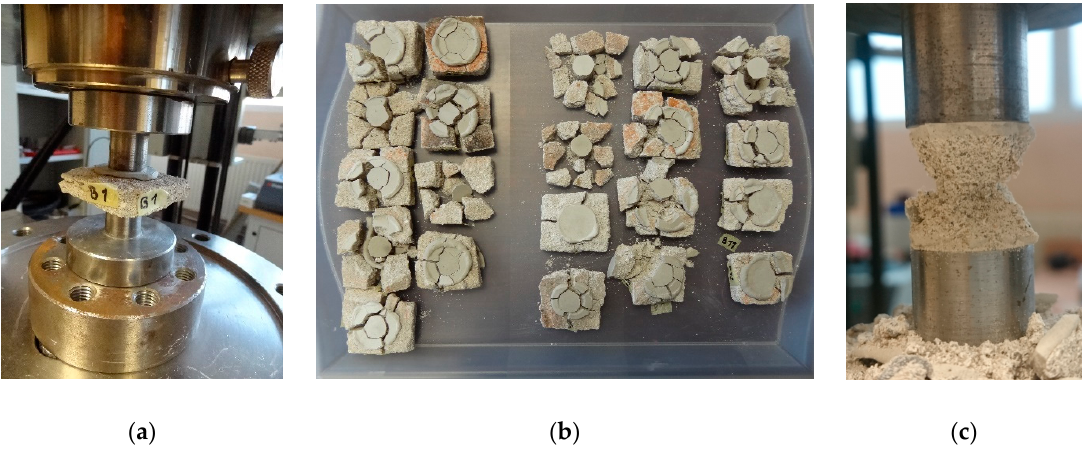
Figure 6. DPT test: ( a ) mortar specimen during loading; ( b ) the failure mode of specimens taken from building B3 and B4—top view; ( c ) a typical failure mode of the mortar specimen between steel punches. Table 2. Results of double punch tests (DPT) on mortar specimens extracted from bed joints of historical masonry.